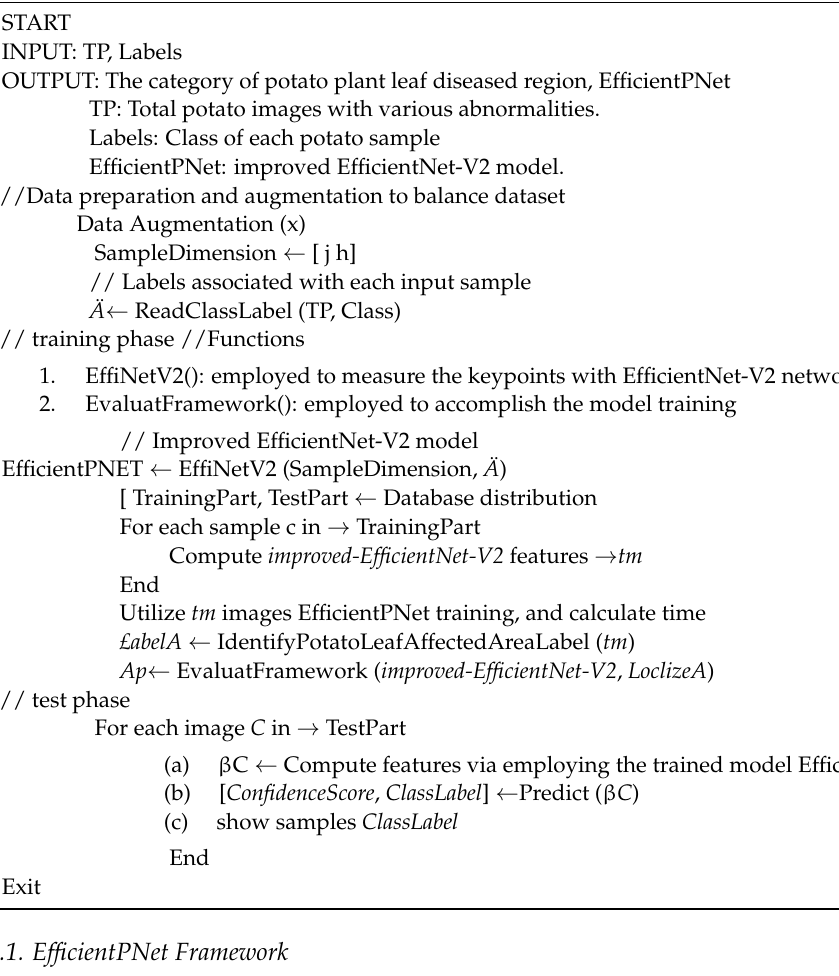
Algorithm 1: Steps followed by EfficientPNet for potato plant leaf abnormality